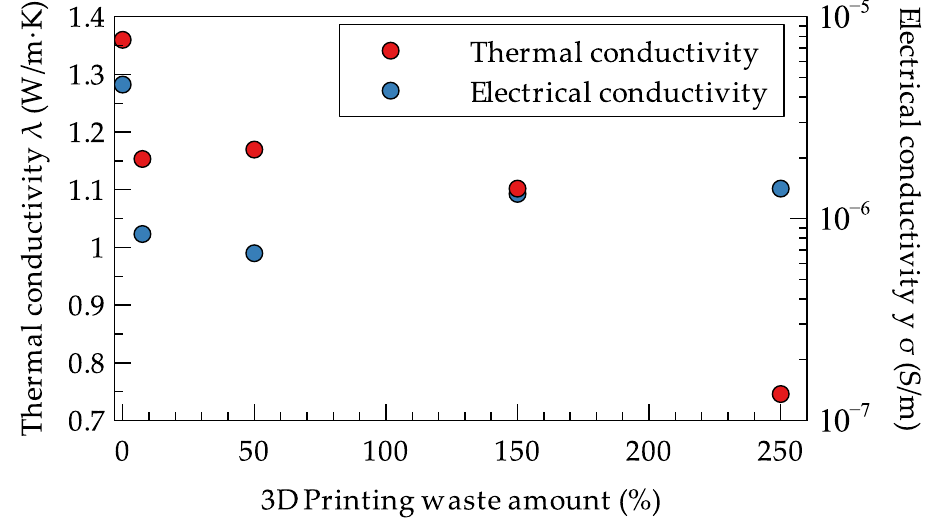
Figure 11. Thermal and electrical conductivity.